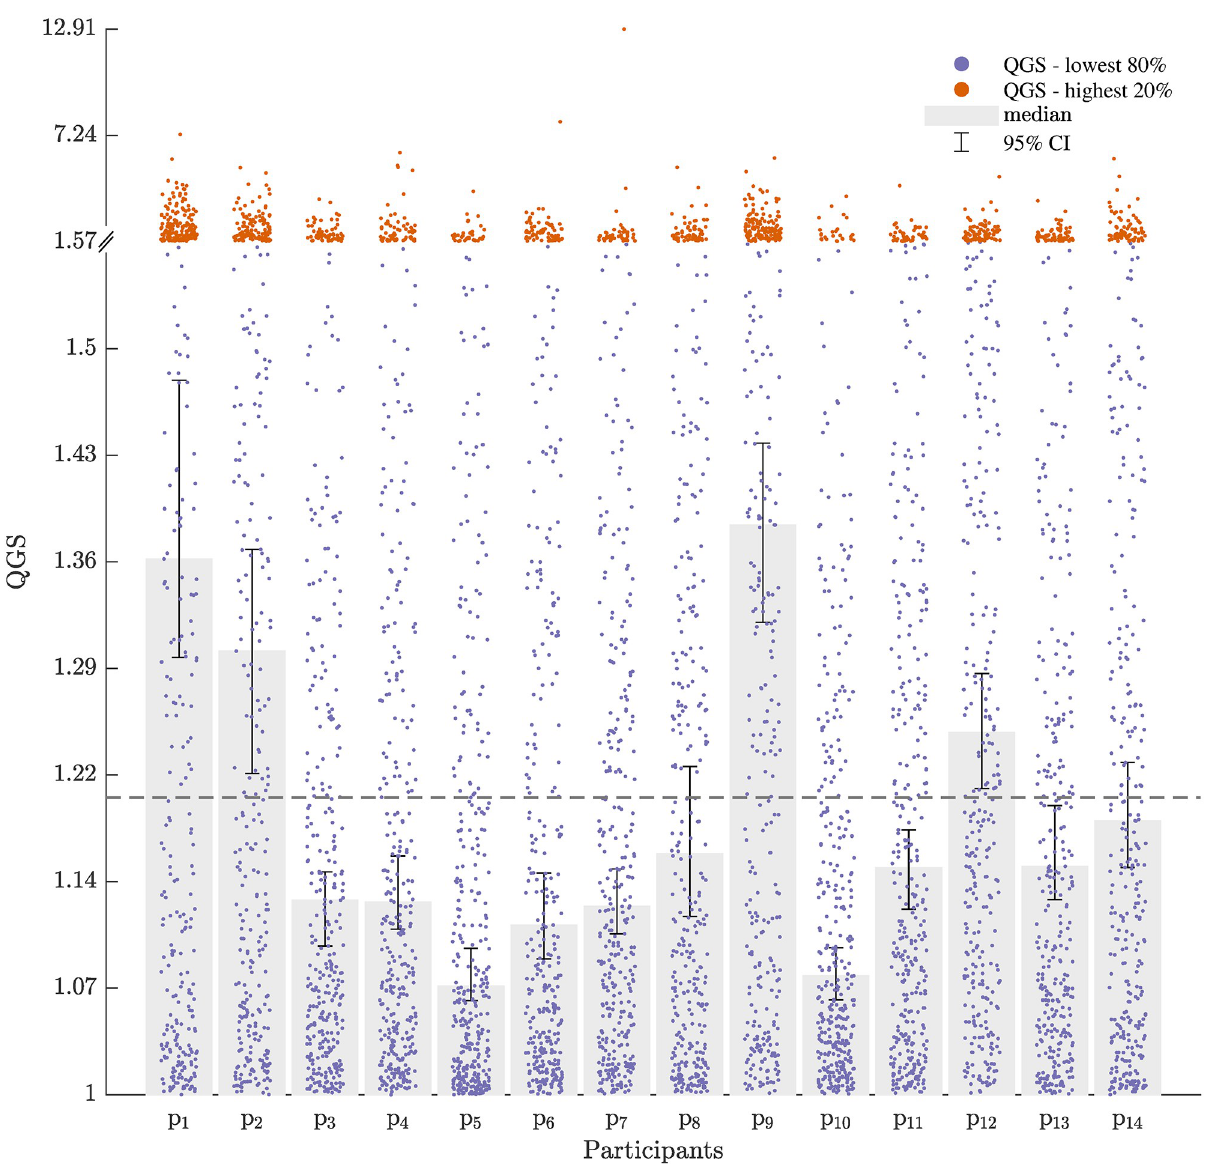
PLOS Computational Biology | https://doi.org/10.1371/journal.pcbi.1010248 December 5,